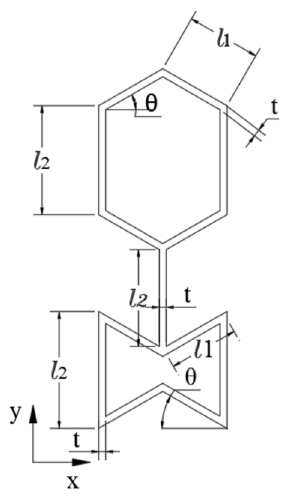
Figure 2. Honeycomb cell with zero Poisson’s